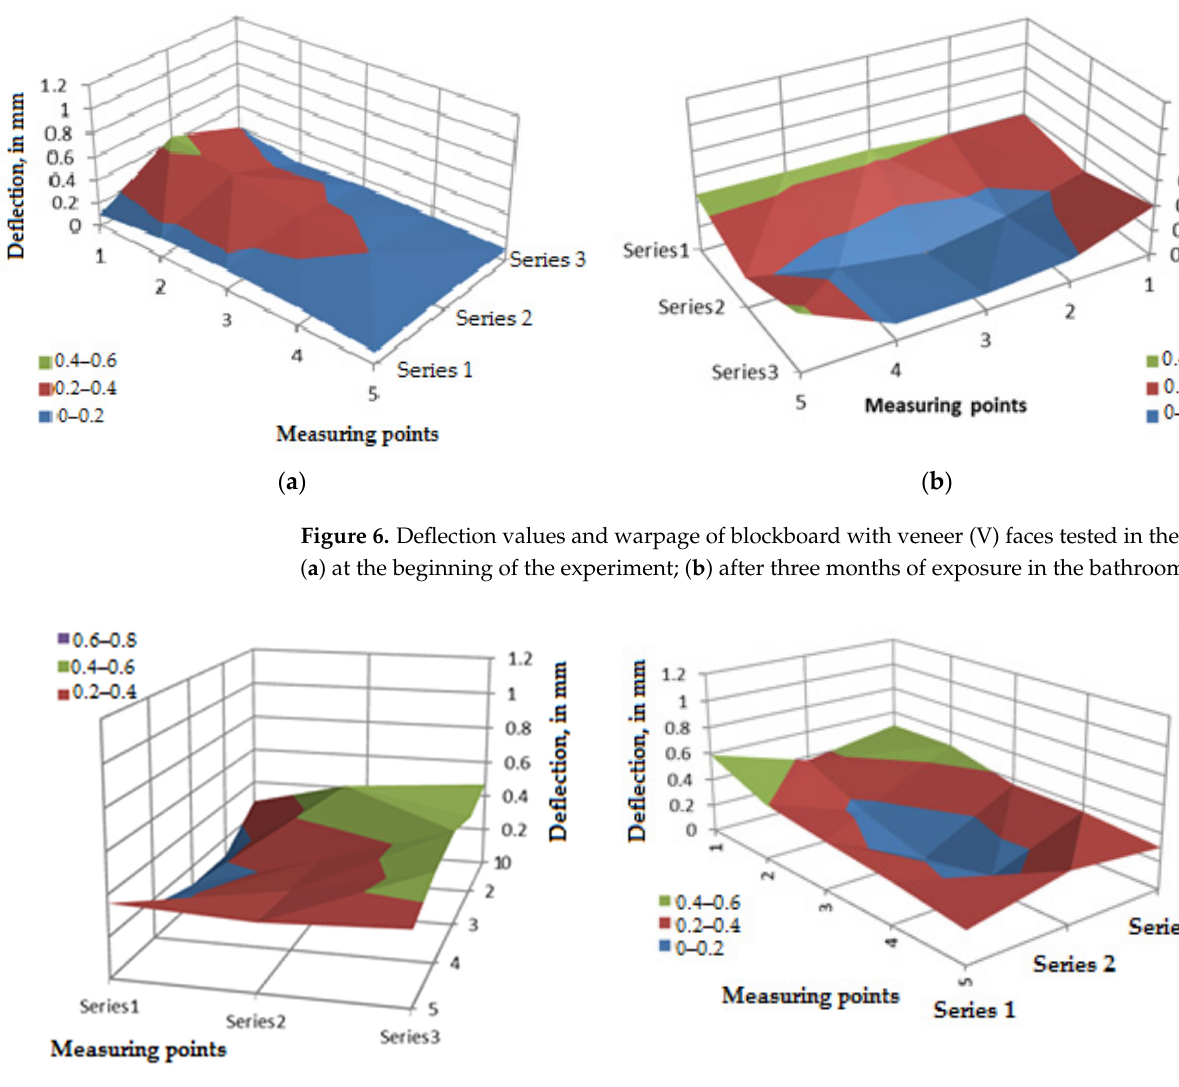
Figure 6. Deflection values and warpage of blockboard with veneer (V) faces tested in the bath- room: ( a ) at the beginning of the experiment; ( b ) after three months of exposure in the bathroom.